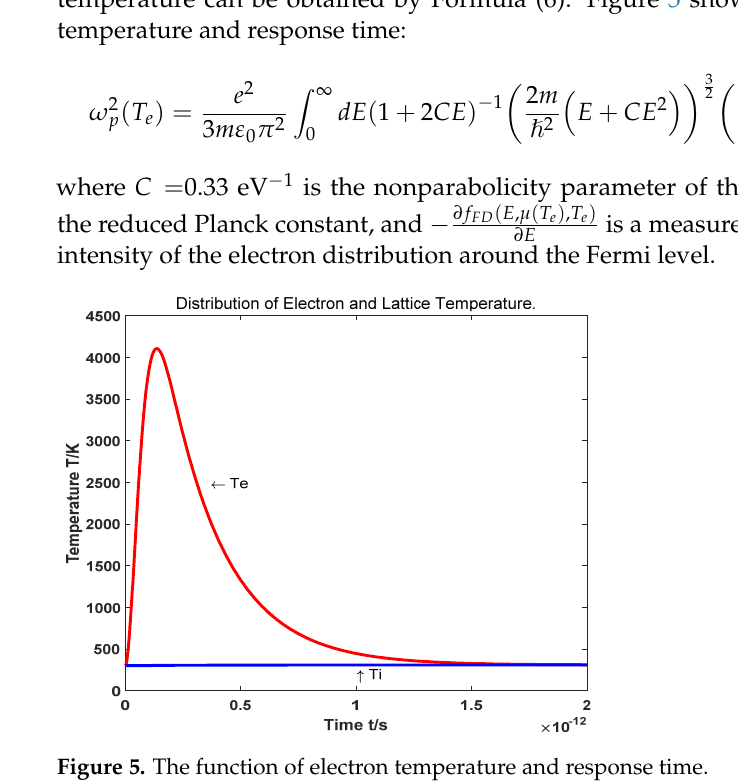
Figure 5. The function of electron temperature and response